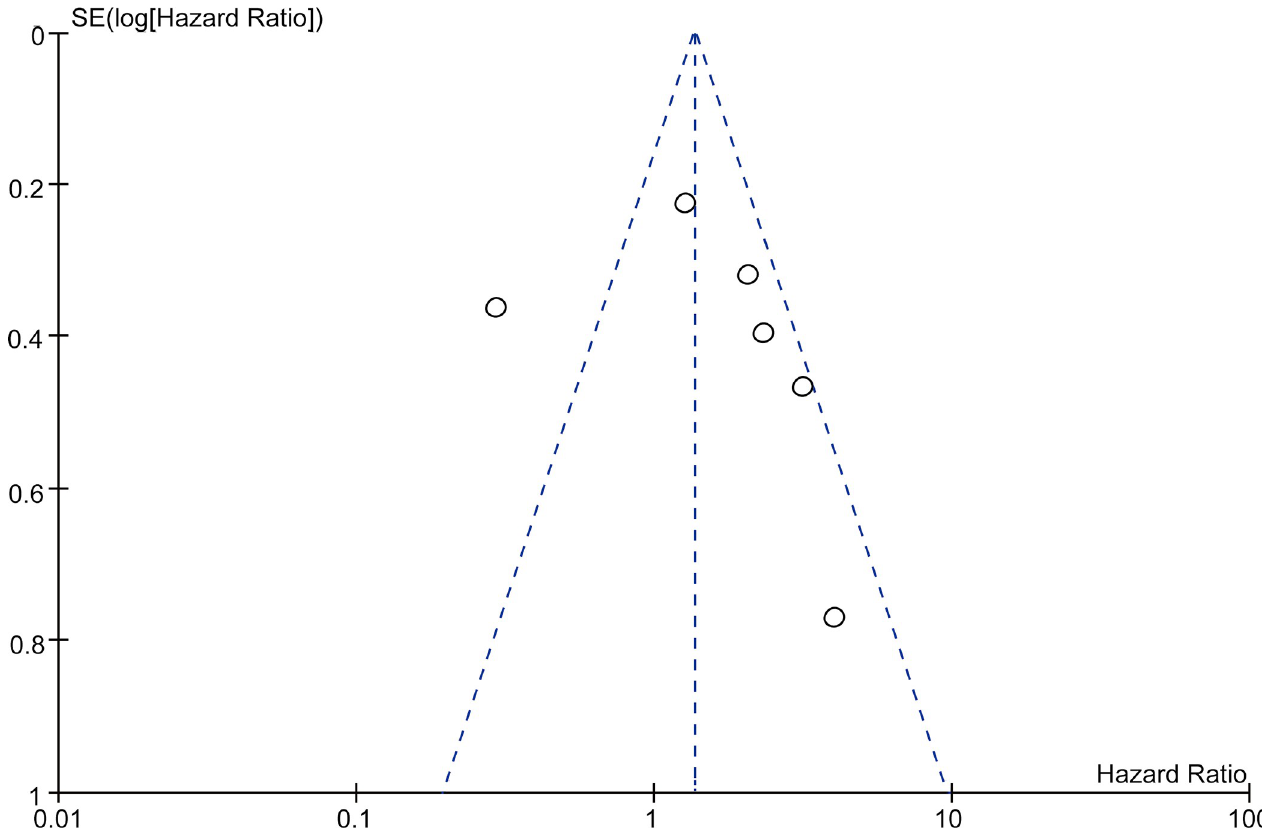
Fig 5. Funnel plot of studies with overall survival as the evaluation